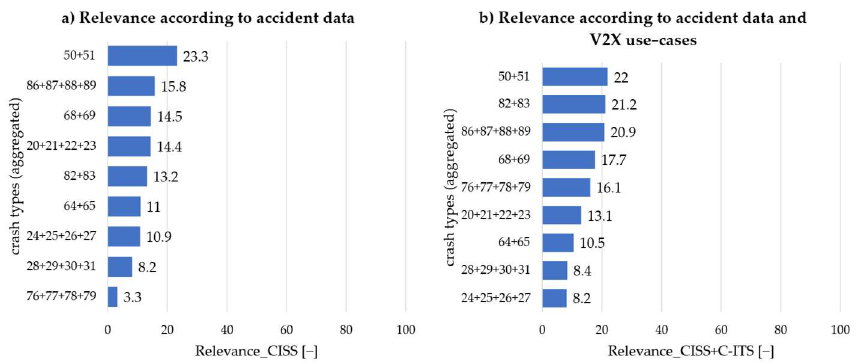
Figure 8. Sorting of the aggregated crash types according to importance (0 to 100): ( a ) without taking V2X into account; ( b ) with taking all relevant use-cases (approach 2) into account.